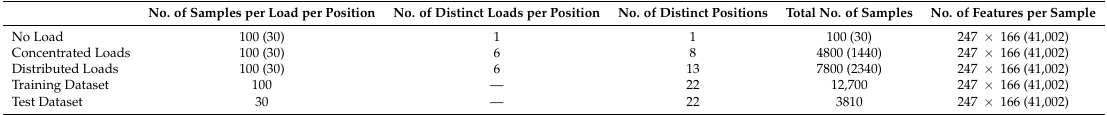
Table 2. Training and test